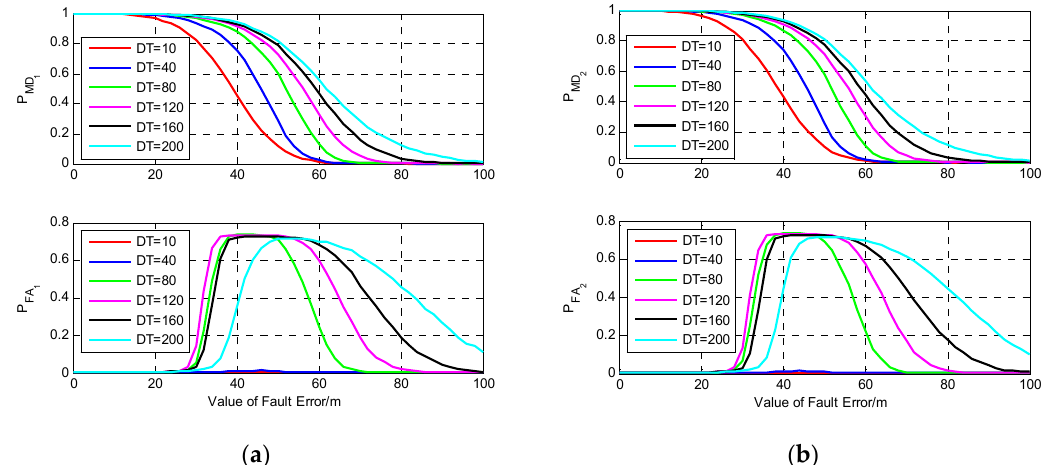
Figure 8. The results of fault detection with two visible satellites. ( a ) Fault occurs on S1; ( b ) Fault occurs on S2.